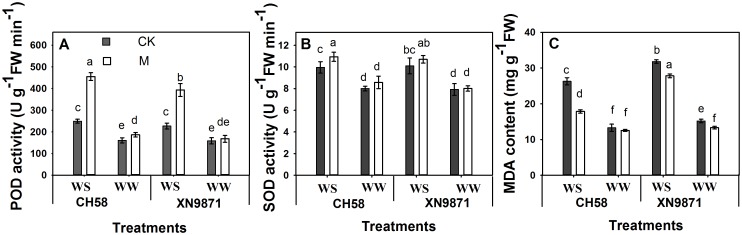
Effects of organic fertilizer on flag leaf (A) POD activity, (B) SOD activity and (C) MDA content of two wheat cultivars under water stress and well-watered conditions at 14 d after anthesis.CK: control; M: organic fertilizer; WS: water stress; WW: well-watered. All data were presented as the mean± SD of six replicates. Duncan’s multiple range test in the SPSS System was used to separate the means, different lowercase letters represent significant different (P≤0.05).